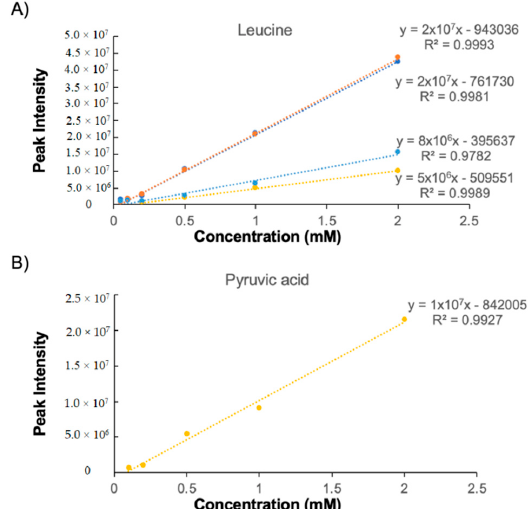
Figure 2. NUS HSQC peak intensity is linear with concentration. Resonance intensity for leucine which has four resonances ( A ) and pyruvic acid which has a single resonance ( B ) increases as a function of metabolite concentration. The best-fit line for each resonance is described. Table 1. Correlation coefficient ( R 2 ) for measured metabolite resonances.